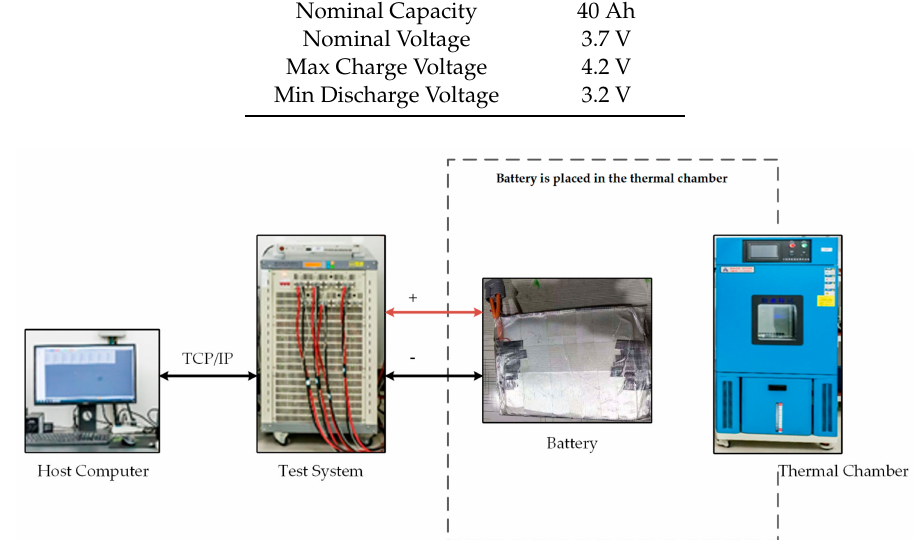
Figure 5. Structure of experimental